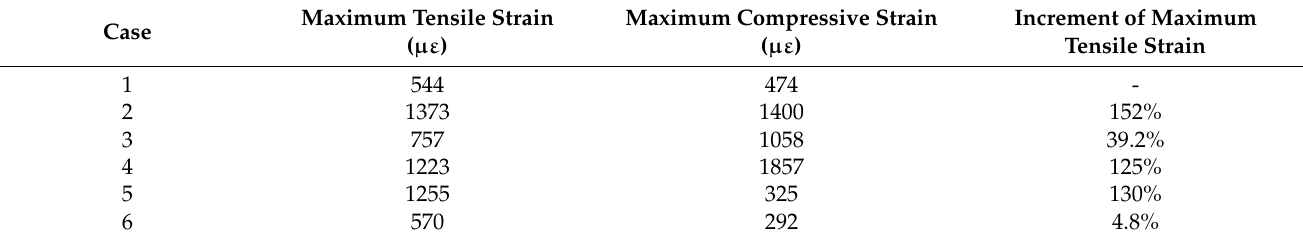
Table 5. The Maximum Longitudinal Strain of